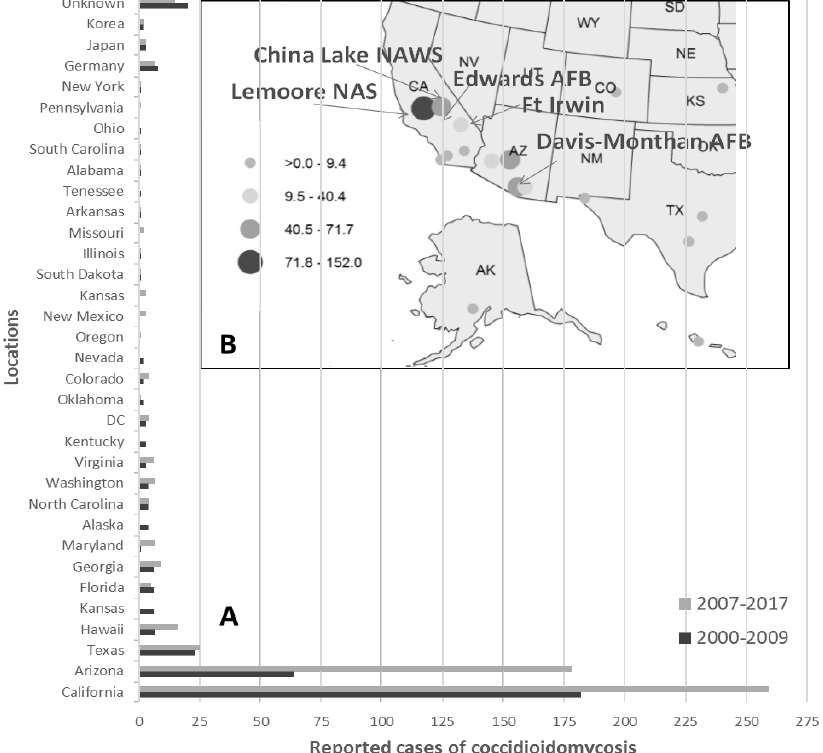
Figure 1. Number of diagnosed cases of coccidioidomycosis between 2000 and 2017 among active military. Data were compiled from two studies: Medical Surveillance Monthly Report (MSMR) 2010 Vol. 17(12):13 [25], and MSMR 2018 Vol. 25(4):2–5 [29] ( A ). Incidence of coccidioidomycosis within the active component, U.S. Armed Forces, 2000–2013 per 100,000 persons / year in the southwestern U.S. (adopted from MSMR 2014, Vol. 21(16):12–14 [26]) ( B ).